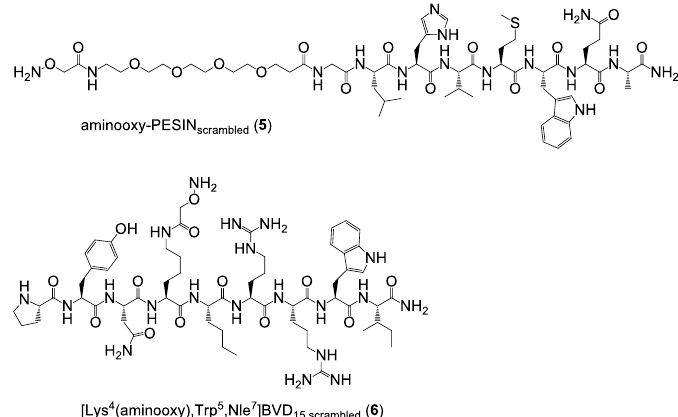
Figure 5. Depiction of the chemical structures of aminooxy-PESIN scrambled ( 5 ) and [Lys 4 (aminooxy), Trp 5 ,Nle 7 ]BVD 15,scrambled ( 6 ) which were used to synthesize partly or fully scrambled HBPL analogs.